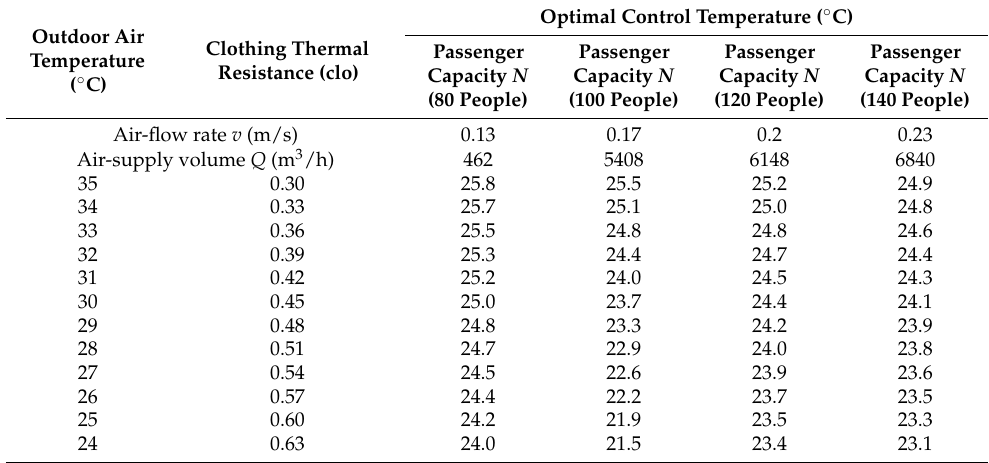
Table 8. The optimal control temperature for a passenger capacity of 60 to 176